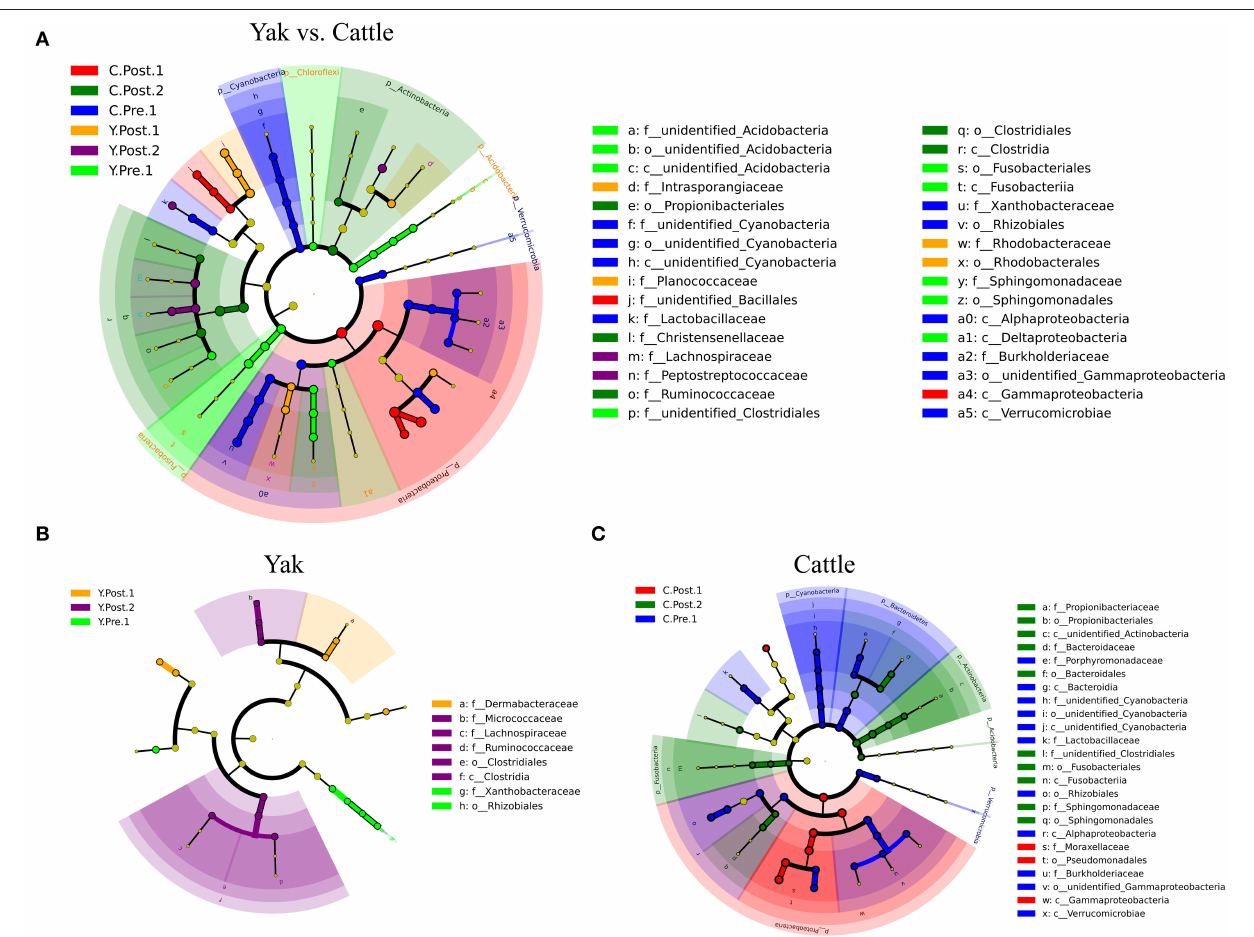
FIGURE 3 | LEfSe analysis of microbial community structure of bovine breast skin during the perinatal period. (A–C) The cladograms indicate the phylogenetic distribution of the udder skin microbiota of yak and cattle during different periods of the perinatal period using the linear discriminant analysis (LDA) effect size (LEfSe) method. The diameters of circles are proportional to the abundance of a taxon. Circles represent taxonomic ranks from domain to species levels from inside to out layers. The LDA cut-off score is 3.5. Letters in front of OTUs represent taxonomic levels (p, phylum; c, class; o, order; f,